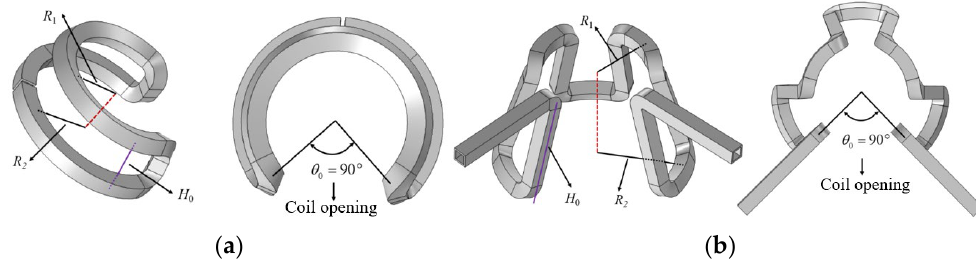
Figure 2. Assembly relationship between the spiral bevel gear and induction heating coil.